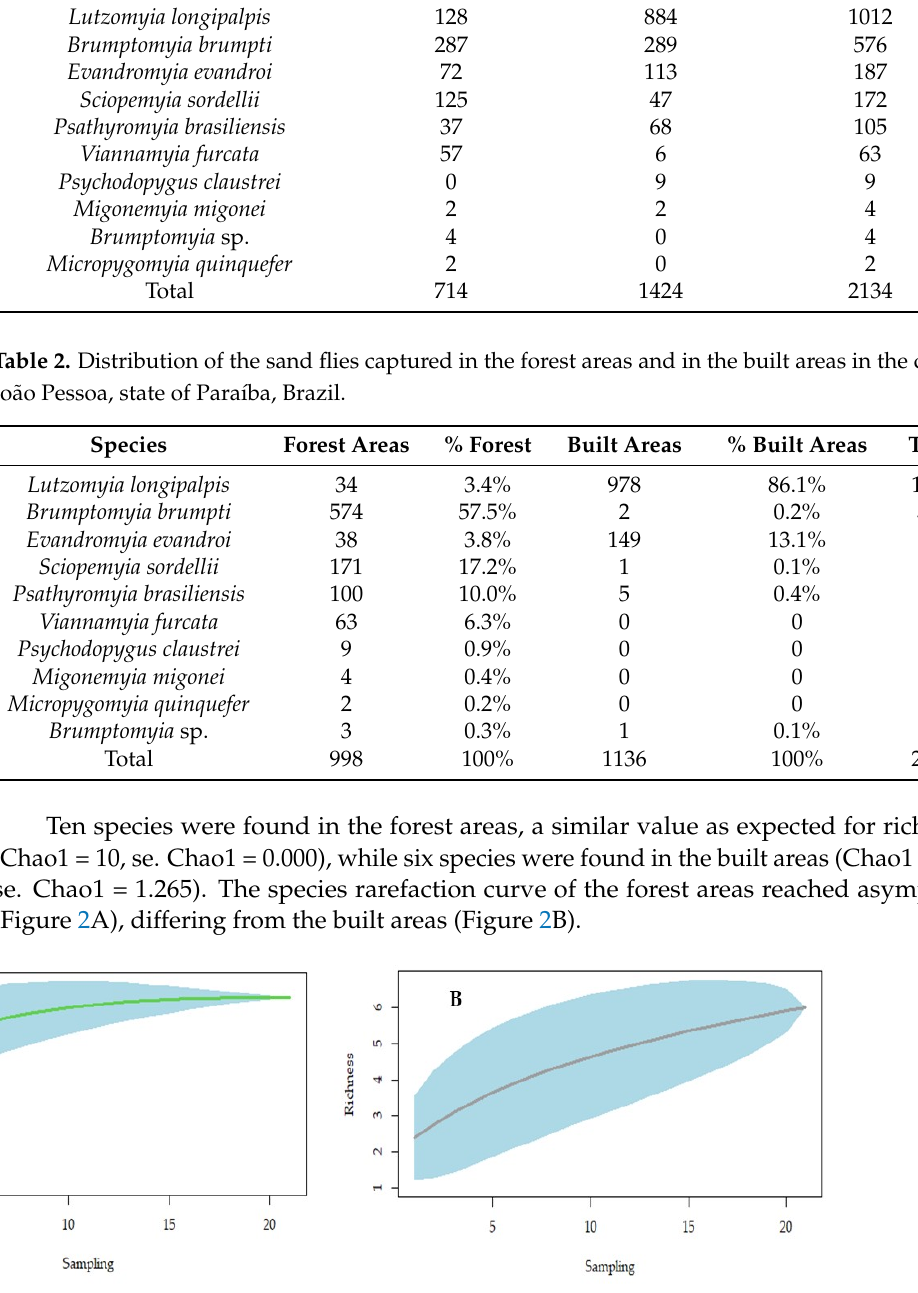
Table 1. Species list, females and males captured in Jo ã o Pessoa, Para í ba, Brazil. Species